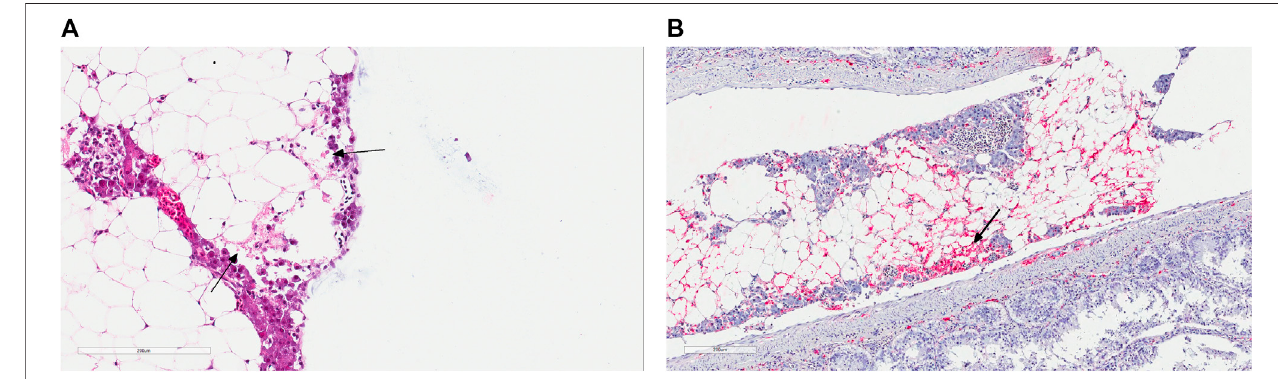
FIGURE1|(A) Histologysection ofthe pancreatic tissue infected withthe infectious pancreatic necrosis virus(IPNV). Arrowsindicate acute necrosisofpancreatic acinar cells. (B) Immunohistochemical staining of the pancreas tissue using antibodies speci fi c for IPNV. Red colours show cells infected with this virus (arrow).